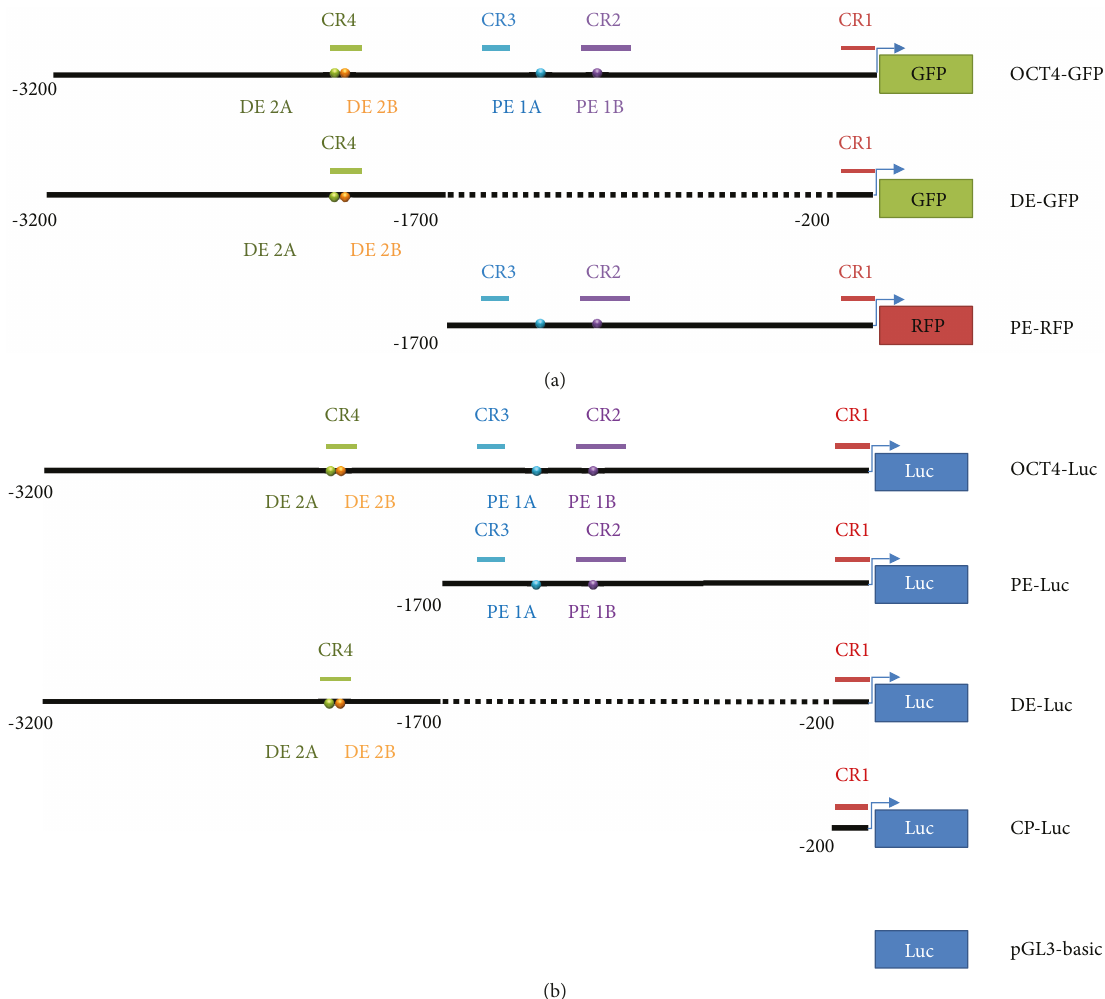
Figure 1: Schematic illustration of the constructed vector using the porcine OCT4 promoter. (a) EGFP reporter vectors carrying di ff erent elements of the pig Oct4 URS were constructed from a pEGFP-N1 vector. One RFP reporter vector carrying a 1.7kb pig Oct4 URS was constructed from a pDsRed2 vector. (b) Four constructs containing the di ff erent elements of the OCT4 promoter in the pGL3-basic vector and the pGL3-basic vector alone as a control were transfected into cells as described in Materials and Methods. DE: distal enhancer; PE: proximal enhancer. The deleted regions are shown as dotted lines.